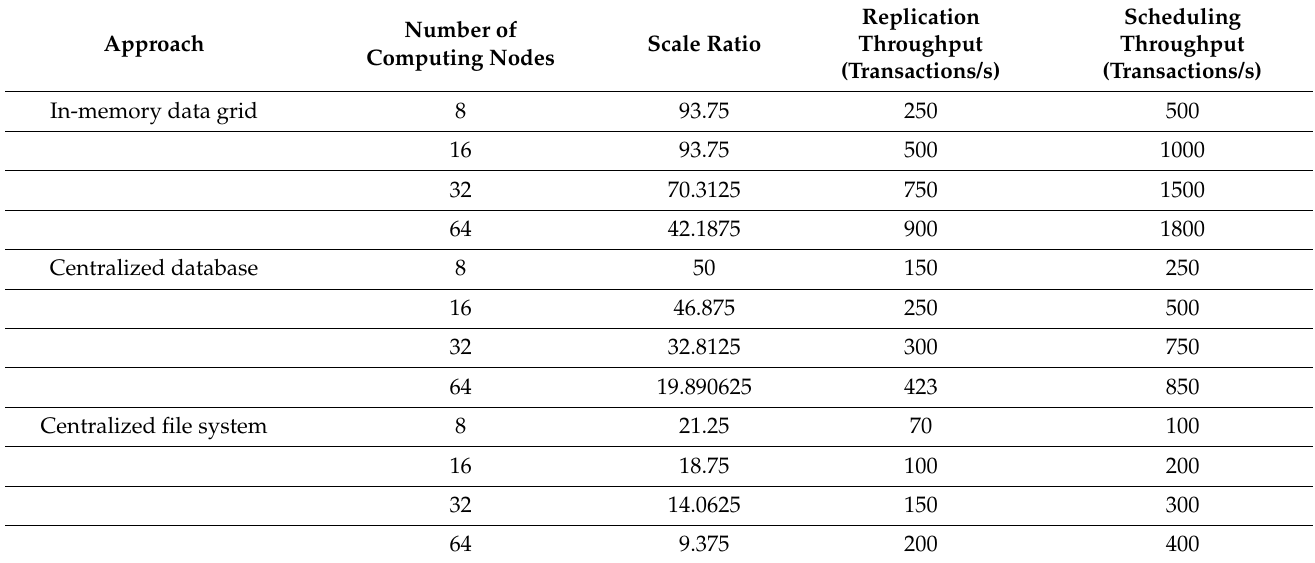
Figure 4. The scalability of replication and scheduling. Table 5. Scalability of replication and scheduling with different